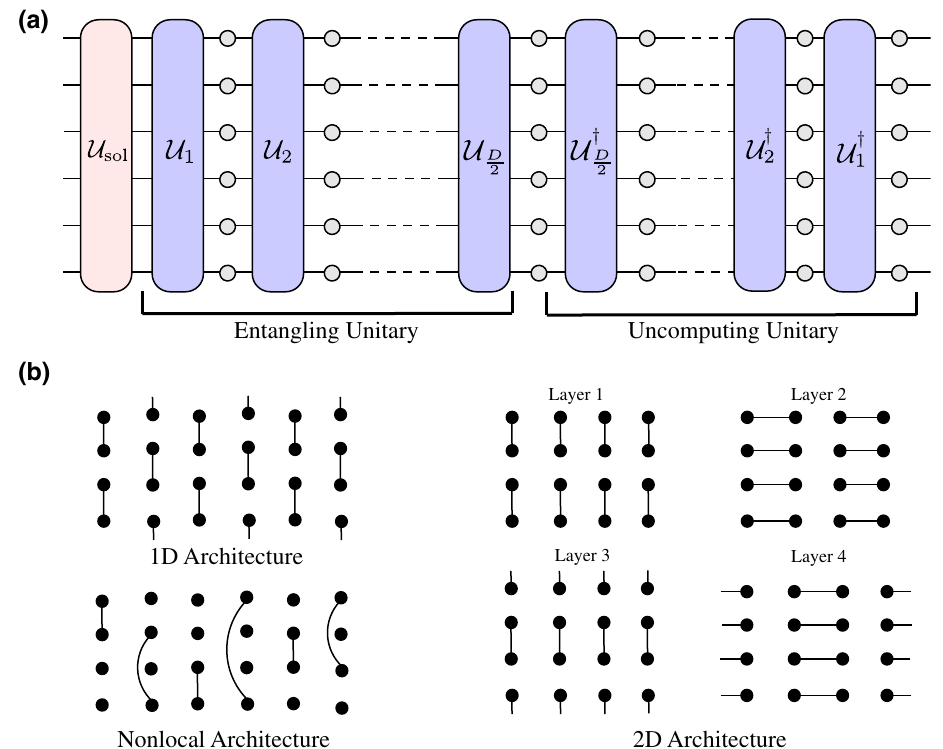
FIG. 1. (a) Schematic depiction of the ensemble of unitary circuits considered in this paper. The circuits consist of an entangling and uncomputing unitary that maps a product state to another product state in the absence of noise. (b) Different circuit architectures (1D, 2D, and nonlocal circuits) studied in this paper. All the circuit architectures are assumed to be translationally invariant—in particular, for the 1D and 2D architectures we assume periodic boundary